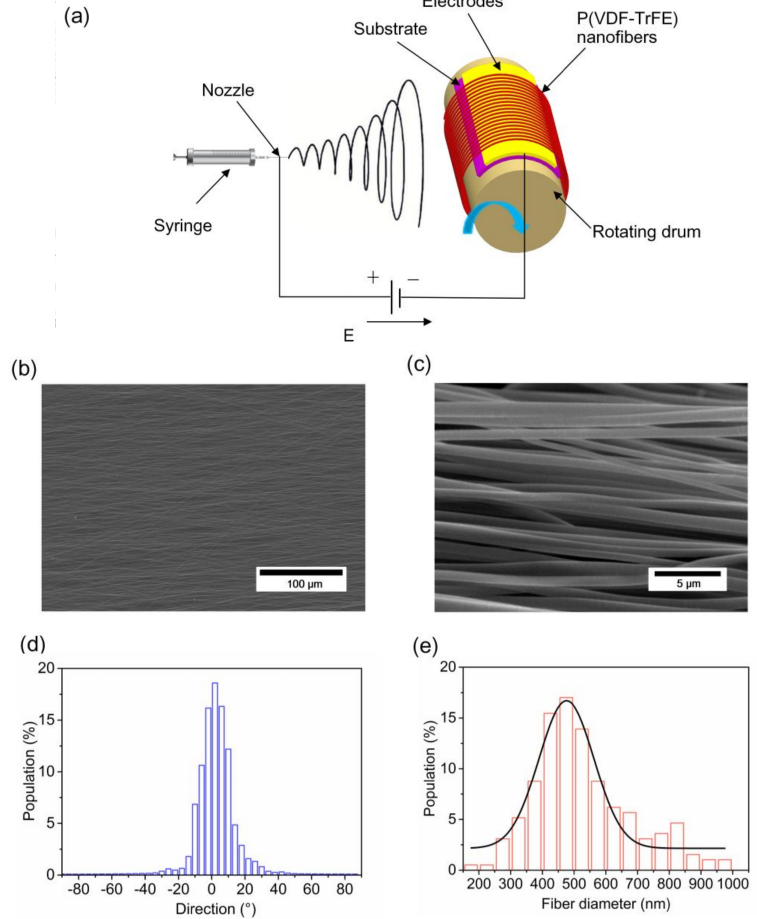
Figure 1. ( a ) Schematic illustration of the far-field electrospinning setup with a rotating-drum collector for the fabrication of highly aligned poly(vinylidene fluoride-trifluoroethylene) (P(VDF-TrFE)) nanofibers. ( b ) Scanning electron microscopy (SEM) micrograph of aligned P(VDF-TrFE) nanofibers. ( c ) Enlarged SEM micrograph of aligned P(VDF-TrFE) nanofibers. ( d ) The degree of nanofiber alignment. ( e ) Typical fiber diameter distribution and fit by a Gaussian curve.